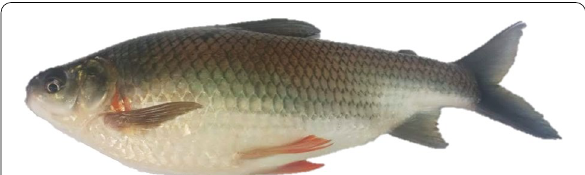
Fig. 1 Prochilodus magdalenae breeding